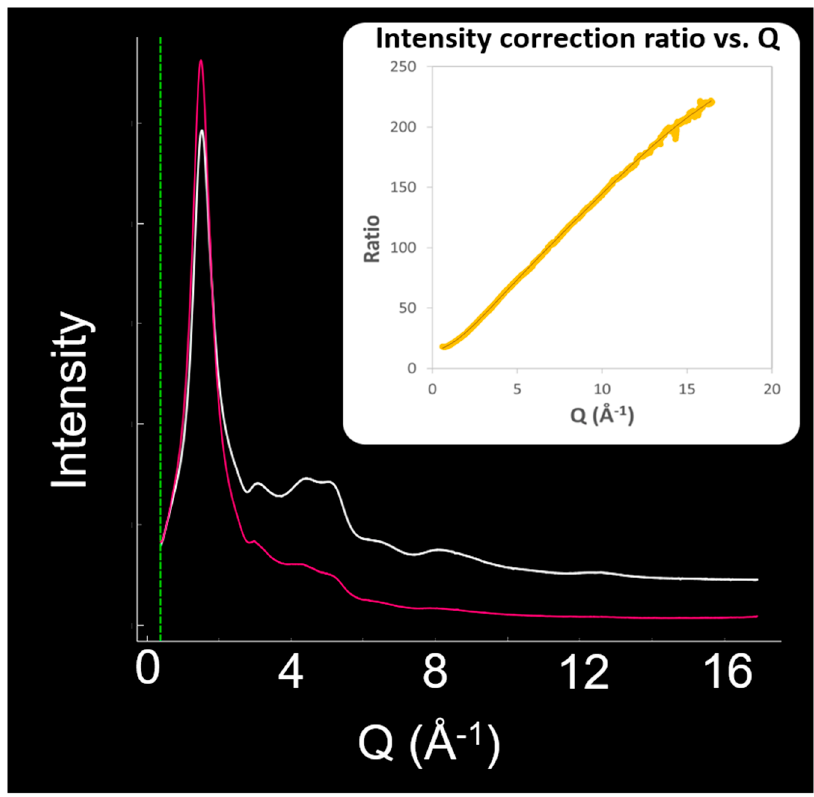
Figure 7. Two sets of X-ray scattering data collected for the same Pyrex glass rod at ambient condition. The red line (scaled in intensity) is the data set collected using the multi-channel collimator while the white one is without the multi-channel collimator. Both were collected for 600 s. The inset shows an example of the transfer function (intensity correction ratio vs. Q) derived from one of the beamtime setups.